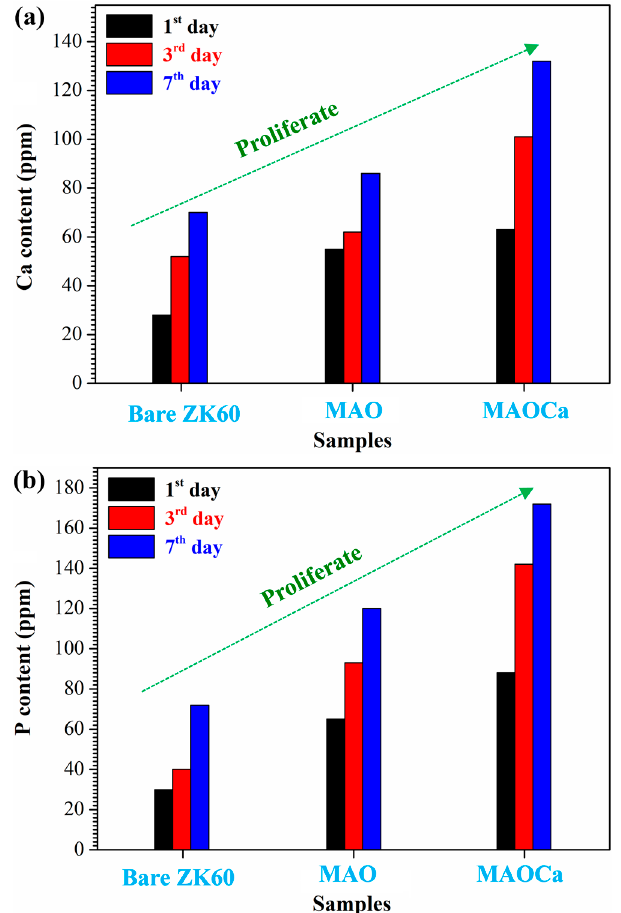
Figure 12. Cell proliferation rates for MG-63: ( a ) Ca and ( b ) P ion release numbers for 1, 3, and 7 days.